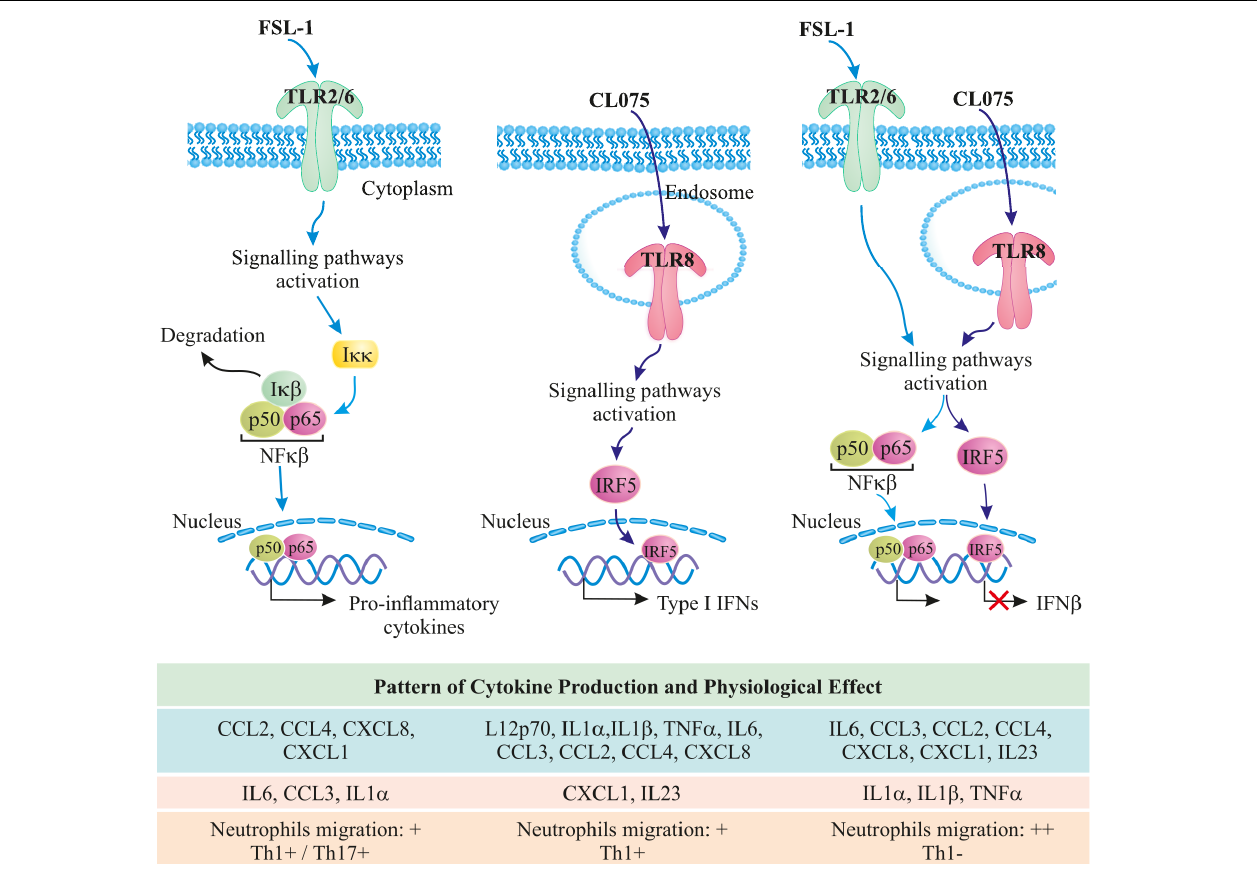
FIGURE 6 | TLR8/TLR2 co-stimulation increases the acute inflammatory response and provides a shift away from Th1 immunity toward increased Th17 immunity; further increasing neutrophil